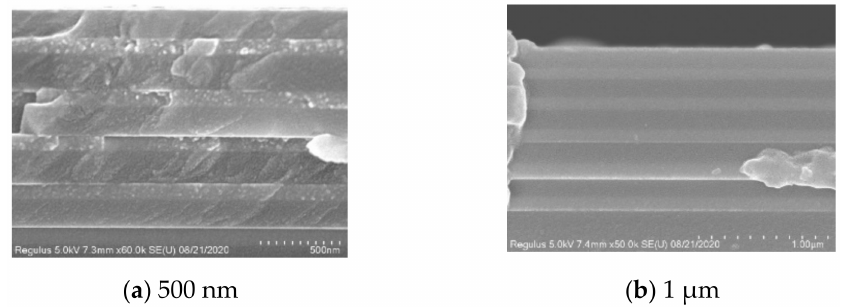
Figure 7. Nb 2 O 5 /SiO 2 multilayer thin film SEM data for 35 sccm Ar.